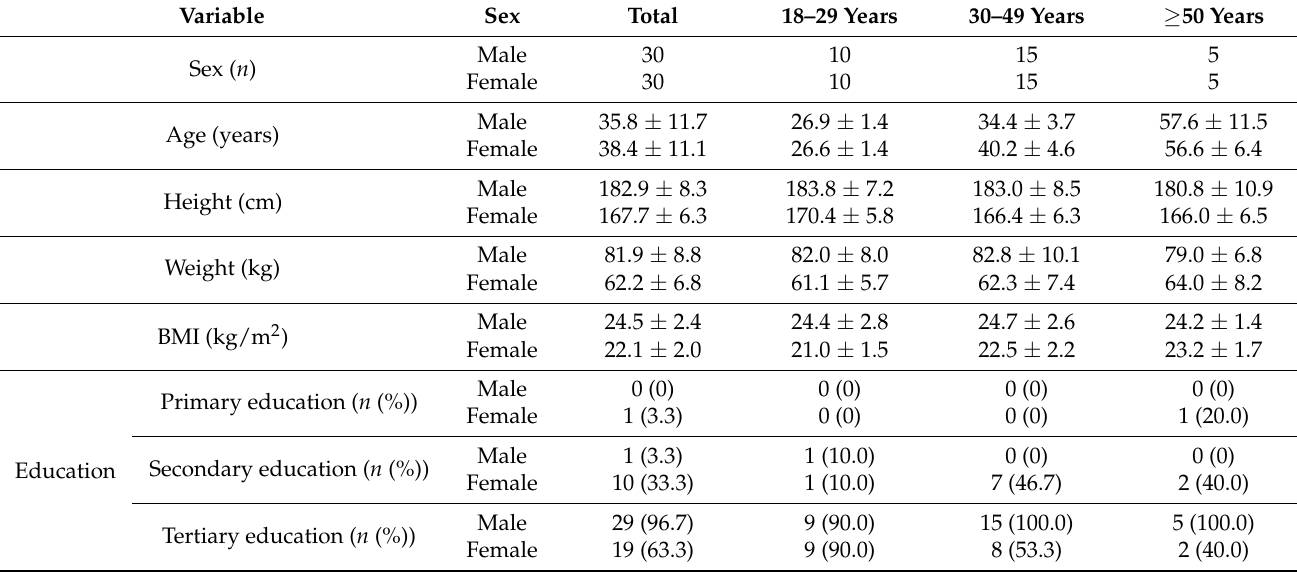
Table 1. Characteristics of subjects in all